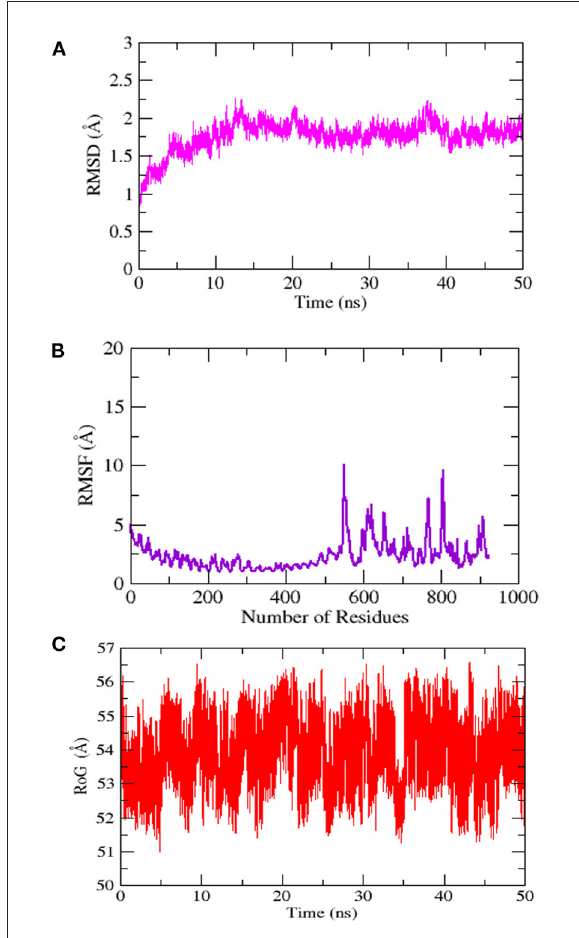
FIGURE11 Simulation trajectories analysis (A) Root-mean-square deviation RMSD (B) Root-mean-square fluctuation (RMSF) and (C) Radius of gyration (RoG).